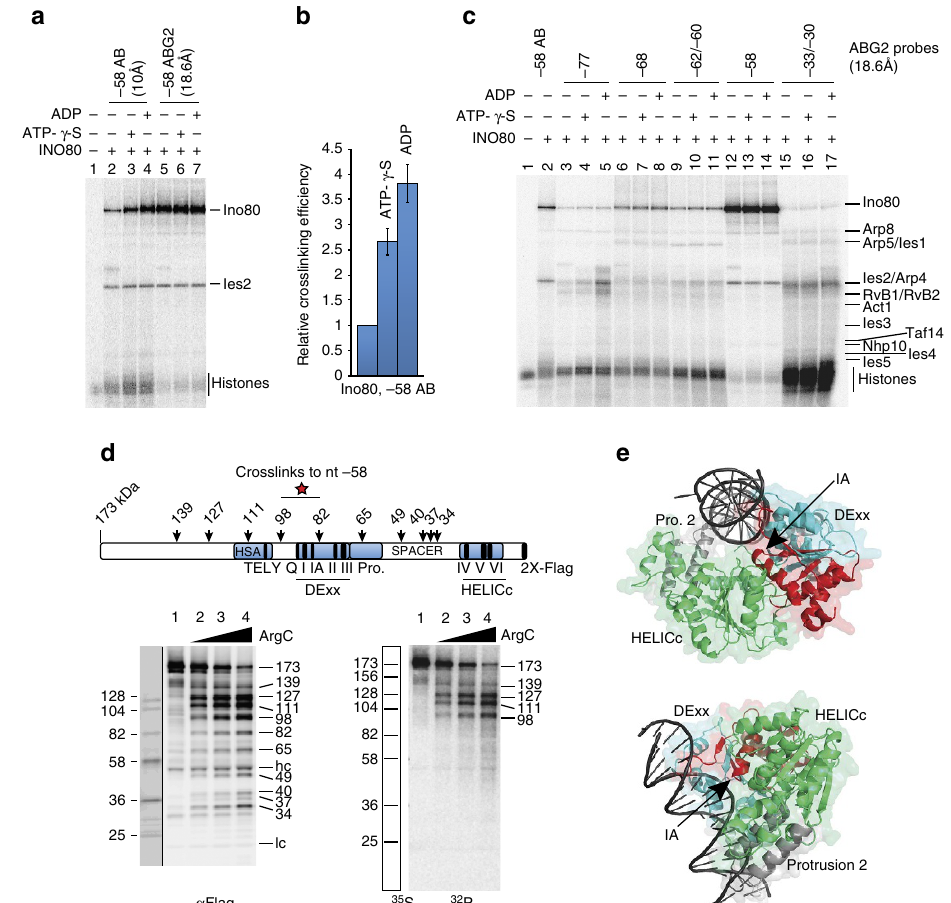
Figure 2 | The ATPase domain of Ino80 engages with nucleosomal DNA 58 bp from the dyad. ( a – c ) Photo-reactive AB-dUMP or ABG2-dUMP nucleotides were incorporated into nucleosomal DNA at nt (cid:2) 58 near SHL (cid:2) 6 ( a ) and other positions ( c ) as indicated for 70N0 nucleosomes. INO80 bound to nucleosomes was crosslinked with or without ATP- g -S or ADP, as indicated by þ or (cid:2) signs. Ies2 was distinguished from Arp4 by immunoprecipitation of Arp4 from crosslinked samples (Supplementary Fig. 1f) ( b ) The efficiency of the Ino80 catalytic subunit crosslinking to nt (cid:2) 58 with a 10Å tether (AB-dUMP), (cid:2) / þ ATP analogues were plotted from panel a, lanes 2–4. Data are representatives of three technical replicates and error bars represent standard deviation of the mean (s.d.) calculated from three technical replicates. ( d ) Peptide mapping of the Ino80 catalytic subunit crosslinked to DNA at nt (cid:2) 58, after digestion of immobilized Ino80 with ArgC. Numbers in the diagram indicate molecular weights of the C-terminal fragments identified by anti-FLAG immunoblotting ( a FLAG image). Sites where proteolysis generates these fragments are indicated along with the locations of conserved domains and motifs in Ino80, and the region crosslinked to DNA. In the immunoblot ‘hc’ and ‘lc’ indicate, respectively, the antibody heavy and light chains. ( e ) Structural model of the Ino80 ATPase domain bound to DNA. The helicase motif IA is in close proximity with the minor groove of the 3 0 –5 0 DNA strand. The DExx domain is coloured cyan, the HELICc domain green, protrusions 1 and 2 as grey, and the region crosslinked to DNA in DNA in a 145 amino-acid region lying between residues 648 and 793 (corresponding to the 98 and 82 kDa fragments, respectively) (Fig. 2d, compare a -FLAG to 32 P, 35 S ladder, and Supplementary Fig. 1a–d). The same region of Ino80 is crosslinked in the absence of ADP (Supplementary Fig. 1e), demonstrating that this interaction is independent of, but gets stronger on ADP binding. The crosslinked region corresponds to the RecA-like domain I (DExx) of Ino80 encompassing helicase motifs Q, I and IA (Fig. 2d,e), consistent with a homologous region of the ATPase domain of Rad54 from Sulfolobus solfataricus found to bind DNA in its crystal structure 54 . Importantly, motif IA of Rad54 has been implicated in DNA binding and generating the power stroke for DNA translocation 54 . Shown previously, SWR1 binds quite differently to nucleosomal DNA than INO80 and is on the opposite side of the dyad at SHL þ 2 and þ 3 (ref. 48). CX-MS of INO80 with nucleosomal histones found several interactions of a short conserved region of the Ies2 subunit with the Ino80 ATPase RecA1 and RecA2 lobes 50 . Consistently, we find Ies2 to